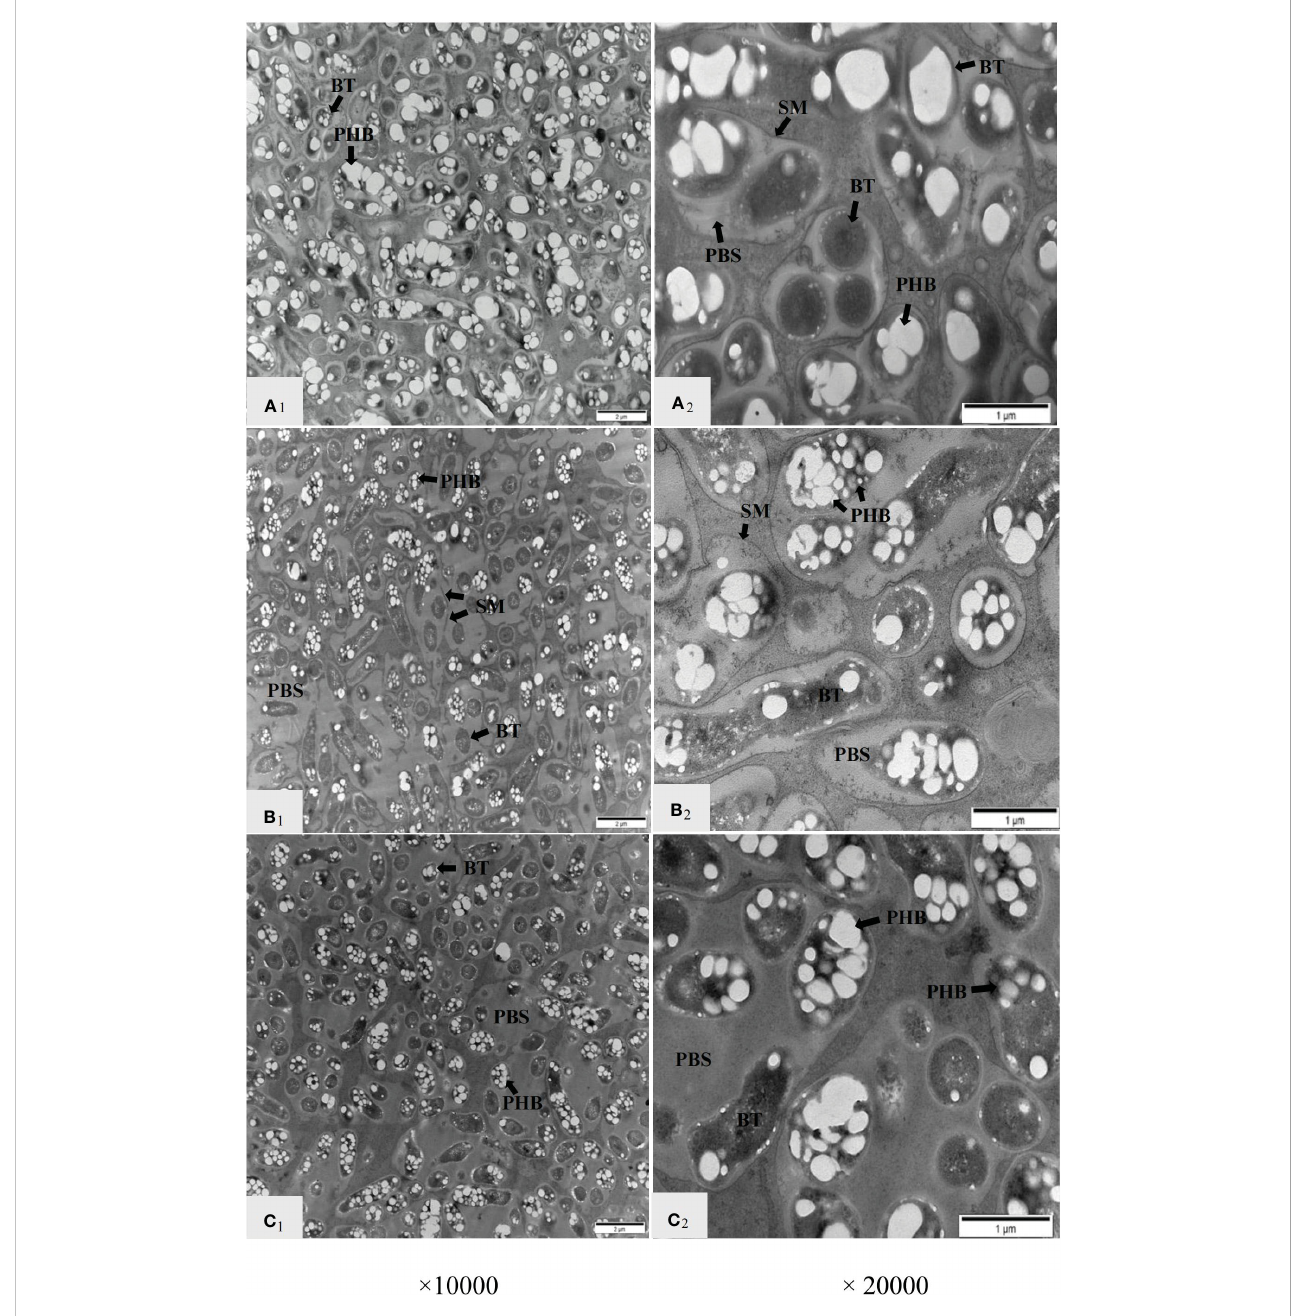
FIGURE 3 Transmission electron micrographs of infected cells in nodules on the nodulating side of dual-root soybean plants. A 1 and A 2 represent the N 0 treatment; B 1 and B 2 represent the N 100 treatment; C 1 and C 2 represent the N 200 treatment. BT, bacteroids; SM, symbiosome membrane; PBS, peribacteroid space; PHB, polyhydroxybutyrate